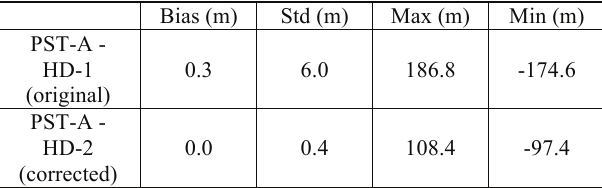
Table 5. Statistics of the differences between PST-A LiDAR DTM and HD-1 DTM / HD-2.